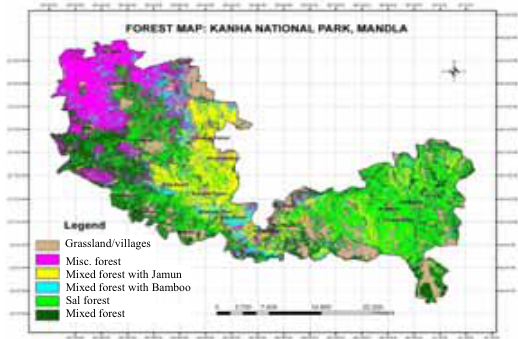
Figure 1. Forest type map of Kanha National Park using IRS- LISS-III and IMS-1 MX data.